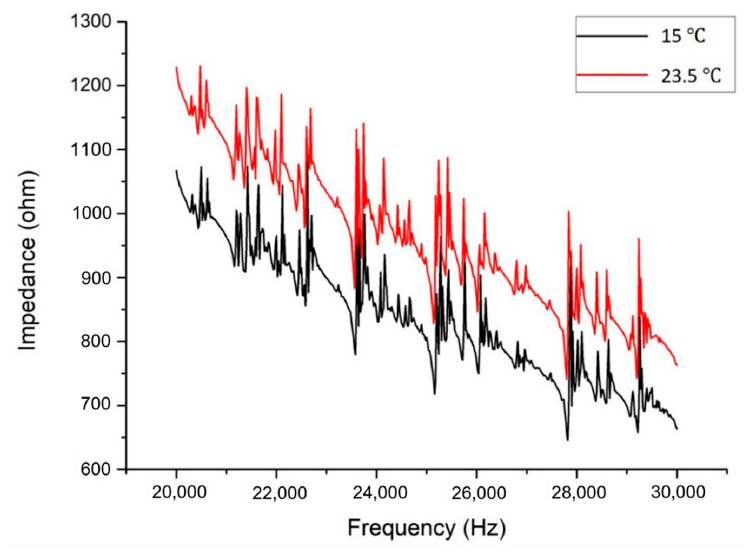
Table 5. Frequency of the first three resonance peaks with temperature variation.